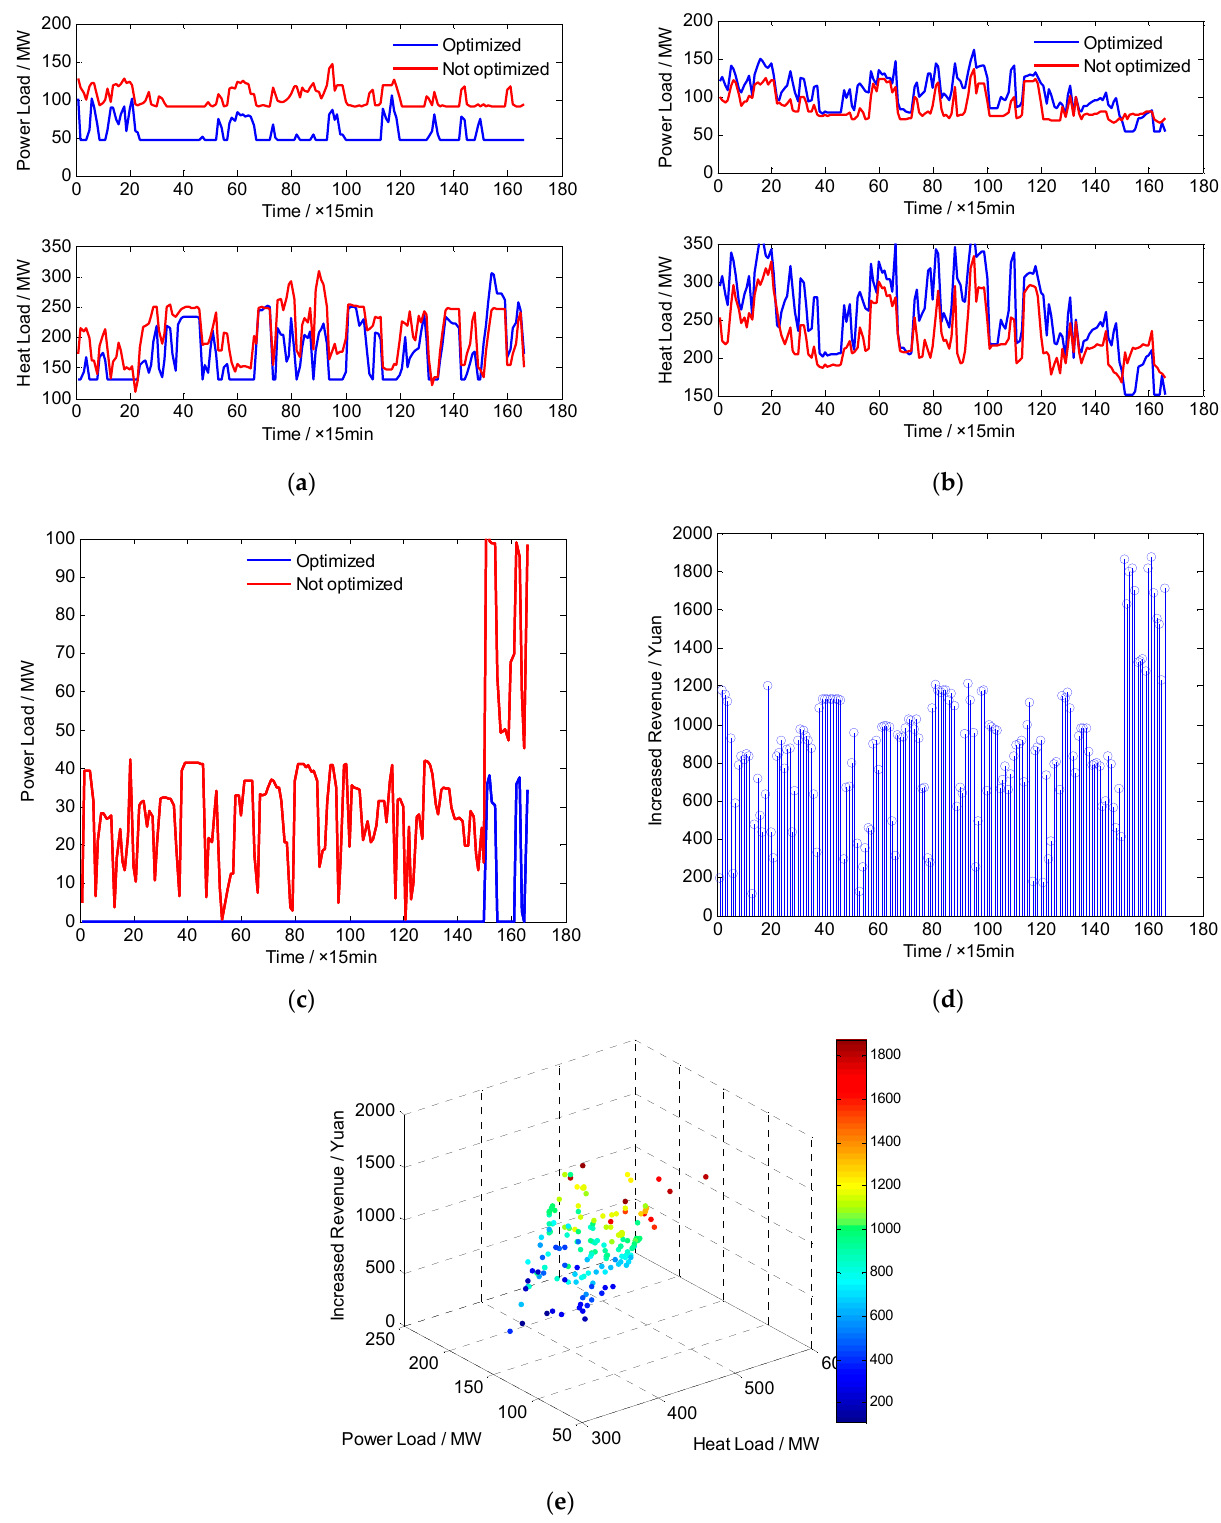
Figure 9. Comparison before and after optimization under mode two (HBP + LPCC + EB) working conditions. ( a ) Electric and heat load of HBP unit. ( b ) Electric and heat load of EH unit. ( c ) Electric boiler load. ( d ) Coal saving before and after optimization. ( e ) Spatial distribution of cost saving potential.